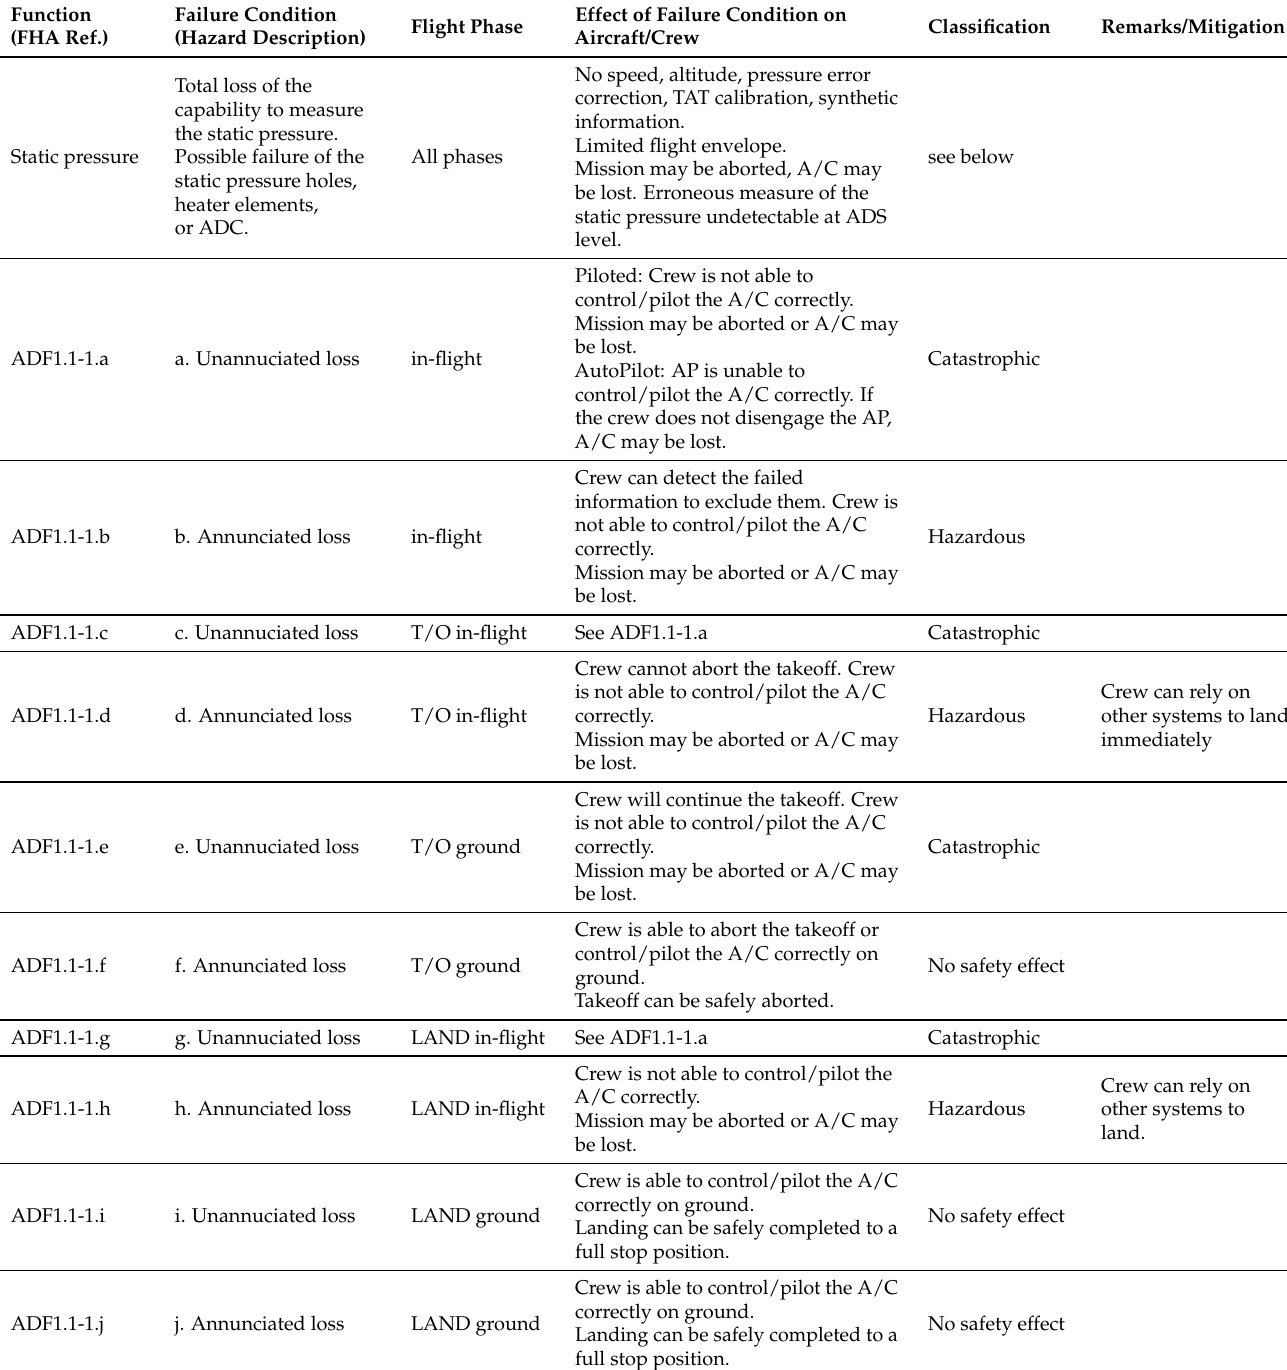
Table A1. ADS FHA for